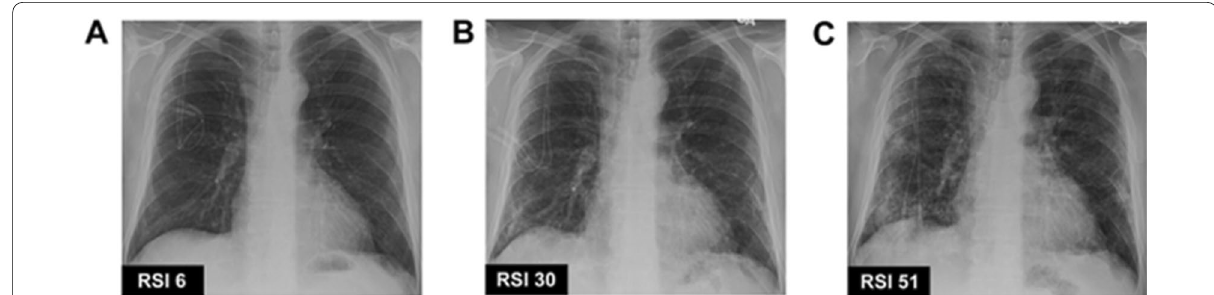
Fig. 1 Representative radiologic severity index score serial for chest X-ray. RSI scores are labelled within each panel. Panels A–C show chest X-ray images from an individual patient with parainfluenza virus-associated lower respiratory infections from the previous study in America, in order of increasing severity